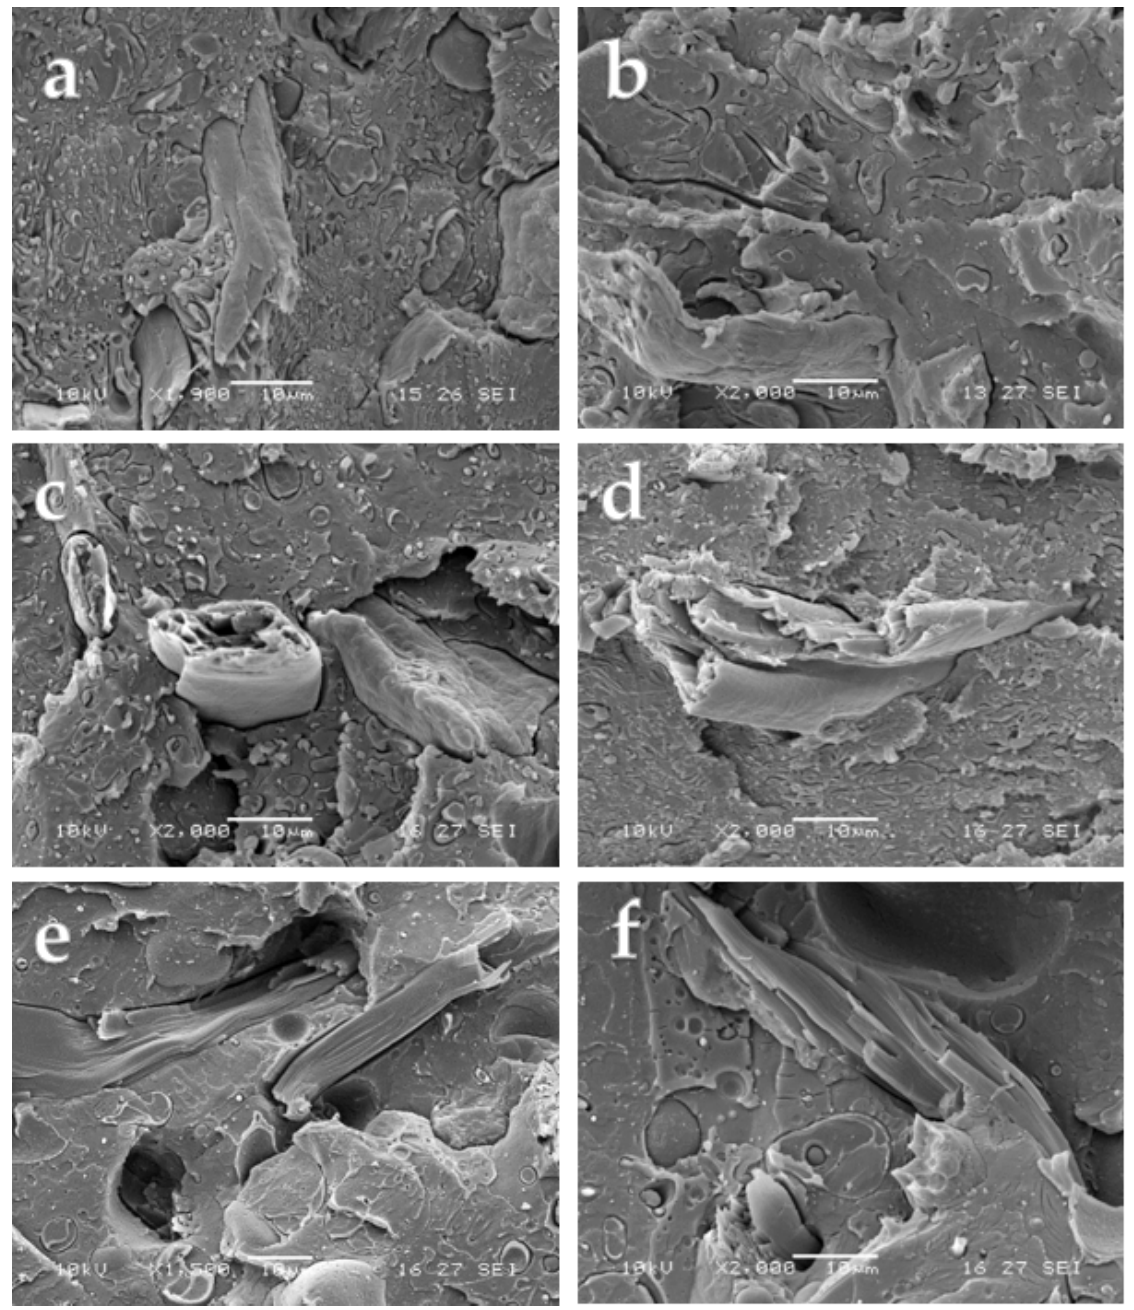
Figure 2. SEM micrographs of cryofractured surfaces of ( a ) R-PLA60/R-PC40+10ArbI; ( b ) R-PLA60/R-PC40+10ArbII; ( c ) R-PLA60/R-PC40+10Lyo; ( d ) R-PLA60/R-PC40+10ArbI+CATA; ( e ) R-PLA60/R-PC40+10ArbII+CATA; ( f ) R-PLA60/R-PC40+10Lyo+CATA. A higher adhesion can be achieved in the presence of TA and TBATPB between matrix and cellulose fibers due to the grafting of PLA and PC chains onto cellulose despite the very short reactive extrusion time; indeed, for the micrographs on the left (without CATA) similar to fibers, gaps were also observed between the R-PLA and R-PC. The